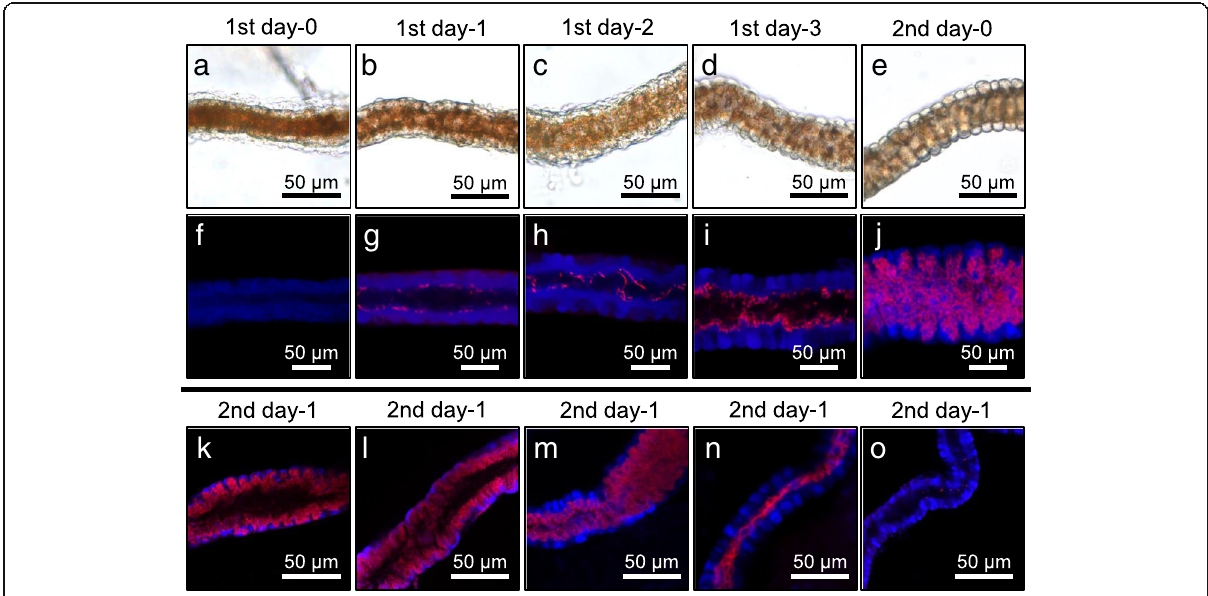
Fig. 5 Morphogenesis of the symbiotic organ at early developmental stages of P. stali . a – e Bright-field images of the symbiotic organs. f – j Confocal microscopic images of the symbiotic organs, in which symbiotic bacteria are visualized by FISH in red and host ’ s nuclear DNA is counterstained in blue. a , f First instar nymph on the day of hatching. b , g First instar nymph 1 day after hatching. c , h First instar nymph 2 days after hatching. d , i First instar nymph 3 days after hatching. e , j Second instar nymph on the day of molting or 4 days after hatching. k – o Confocal microscopic images of the symbiotic organs of second instar nymphs 1 day after molting, where the levels of crypt formation and symbiont colonization exhibit considerable